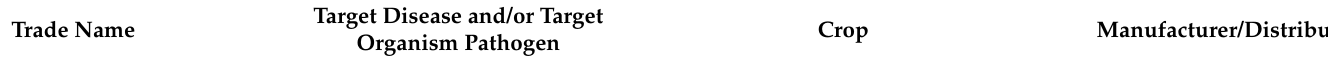
Table 1. Biopesticides, their trade names and targets